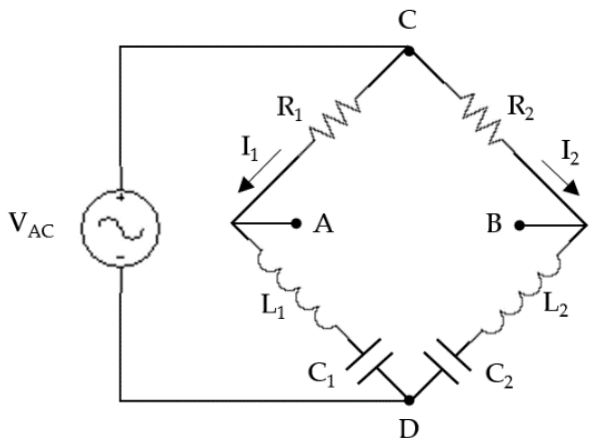
Figure 7. Proposed Maxwell bridge circuit with serial-resonance capacitors.